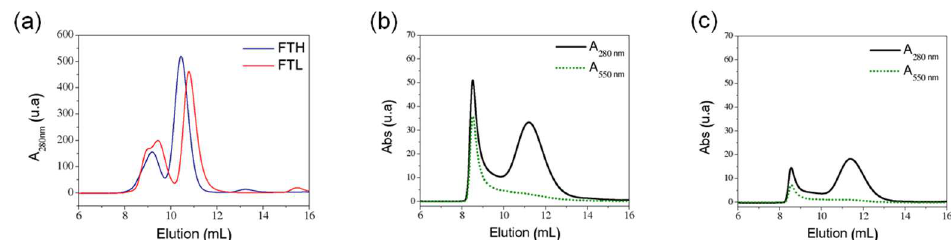
Figure 3. Size exclusion chromatography of FTL and FTH samples. Elution profile of ( a ) ApoFTH and ApoFTL, ( b ) FTH-AuNP and ( c ) FTL-AuNP.